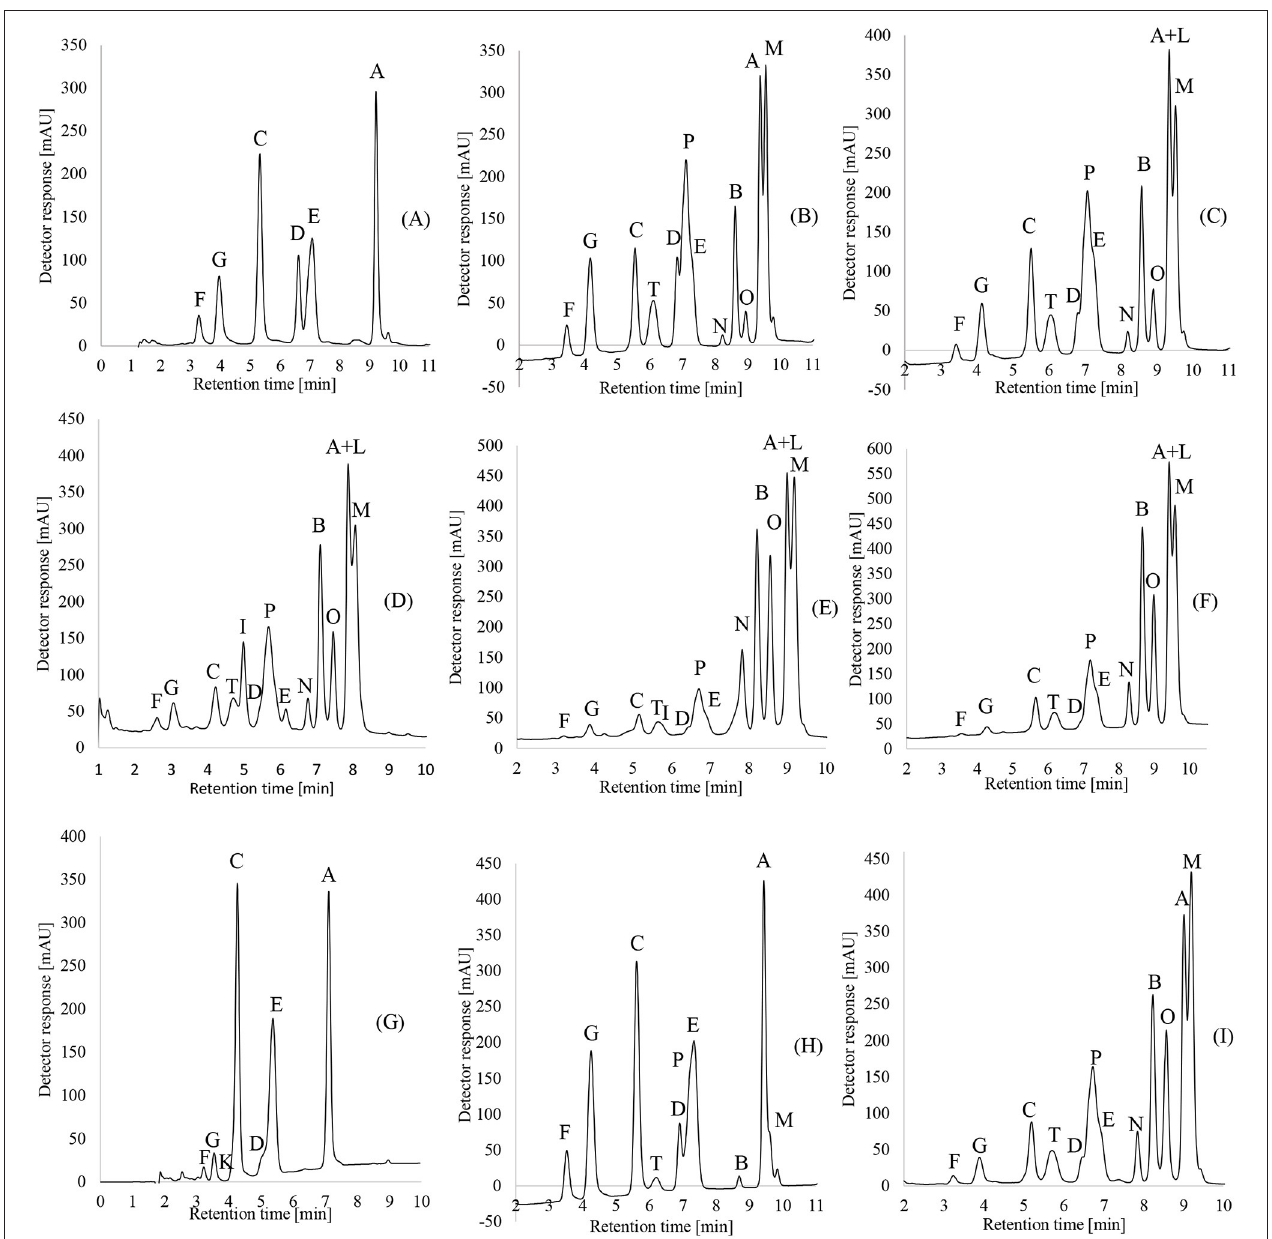
FIGURE 2 | RP-HPLC detection and separations of CLPs from (A) “AN,” (B) “BL,” (C) “SP,” (D) “DM,” (E) “ES,” (F) “FA,” (G) “GA,” (H) “PB,” and (I) “VD” using a Kinetex TM C18 2.6 µ m column. Eluent settings were used: 0.5 ml/min flow rate; methanol and water isocratic elution as described in the “Methods” section. Liquid–liquid extraction was used as the extraction